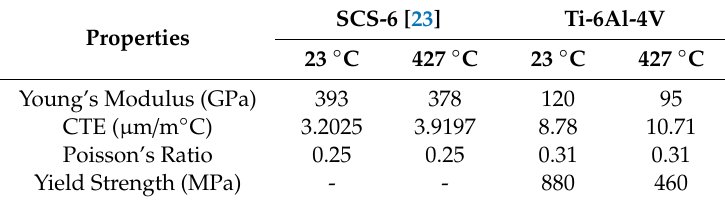
Figure 5. Tensile test data of unidirectional SCS-6/Ti-6Al-4V composite for 0° and 90° loadings at 427 °C. Table 2. Properties of SCS-6 fiber and Ti-6Al-4V matrix